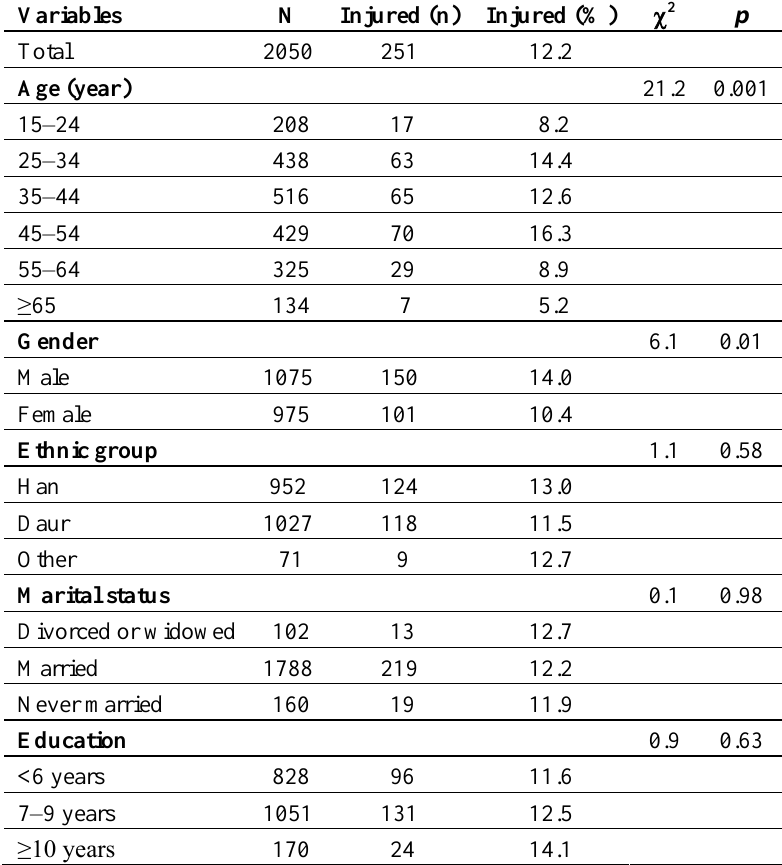
Table 1. Prevalence of agricultural work-related injuries among farmers in a northeastern province,